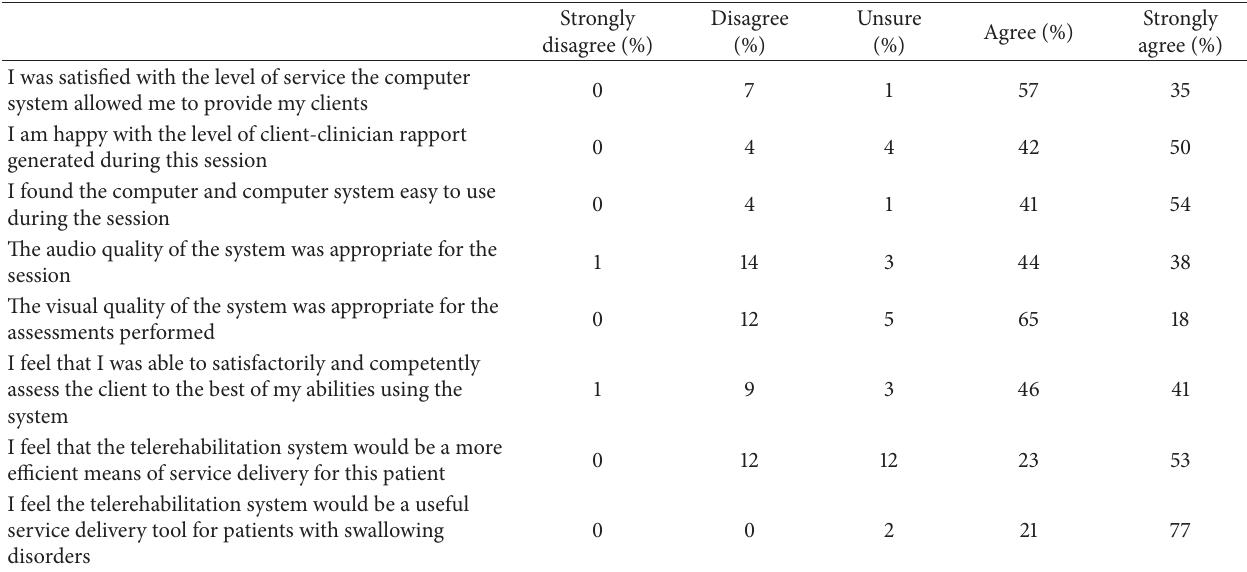
Table 2: Clinician perceptions of the telehealth session ( 𝑛 = 100